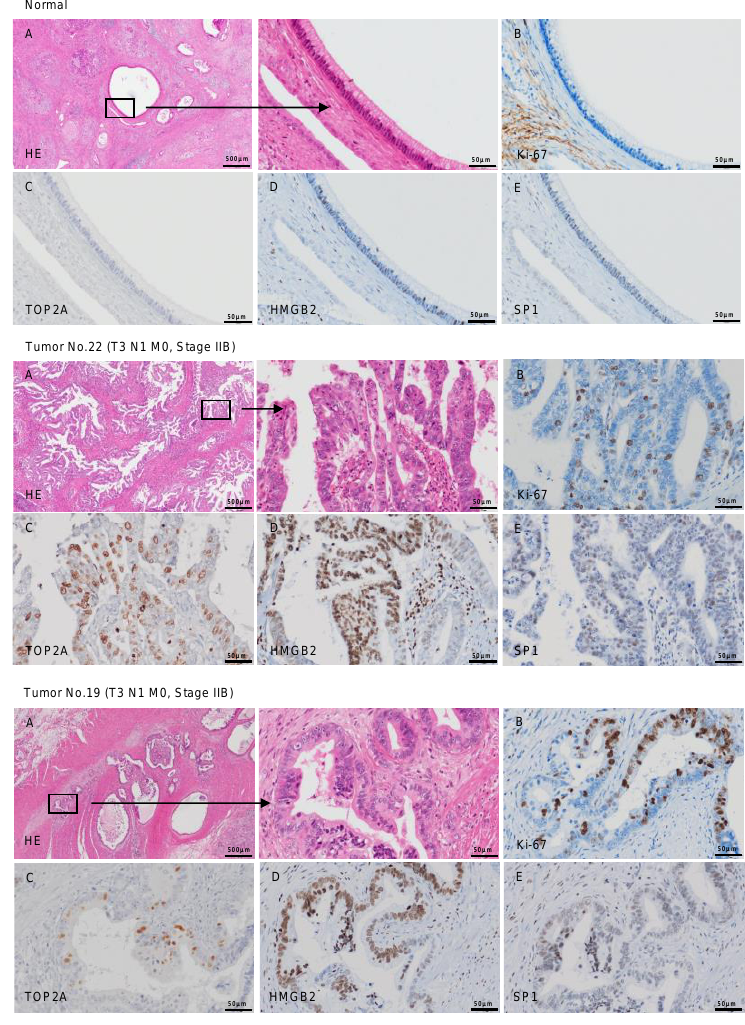
Figure 9. The overexpression of TOP2A , HMGB2 , and SP1 in PDAC clinical specimens determined by immunohistochemical staining. Representative immunohistochemical images for TOP2A , HMGB2 , and SP1 in clinical samples are shown. ( A ) H&E stained sections of human PDAC tissue. Areas in the boxed region at left are shown magnified at right. ( B ) Ki-67 was used as a cell proliferation marker. ( C ) Immunohistochemical staining for TOP2A showed patchy nuclear signals in PDAC. ( D , E ) Immunohistochemical staining for HMGB2 ( D ) and SP1 ( E ) was found in the nuclei of cancer cells. The patient numbers are shown in Table S1.